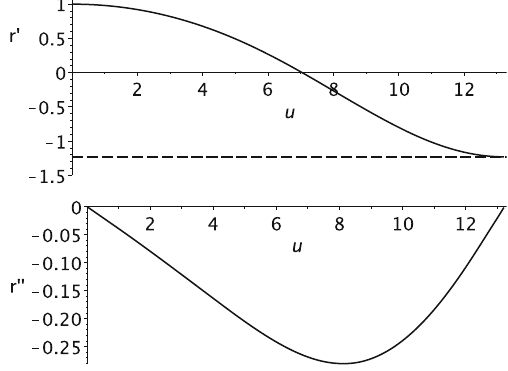
Fig. 4 Additional information about the case discussed in Fig.3